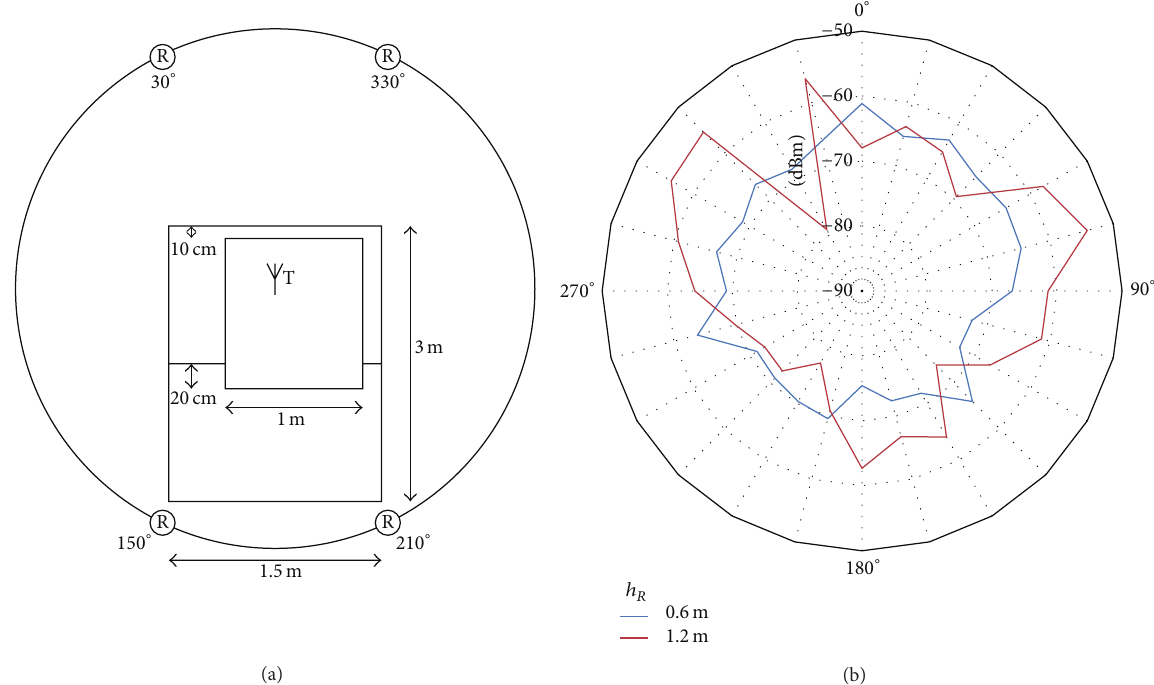
Figure 11: (a) Test scenario for determining the radiation pattern around the 1st type machine tool, for two receiver heights ℎ 𝑅 ; (b) radiation